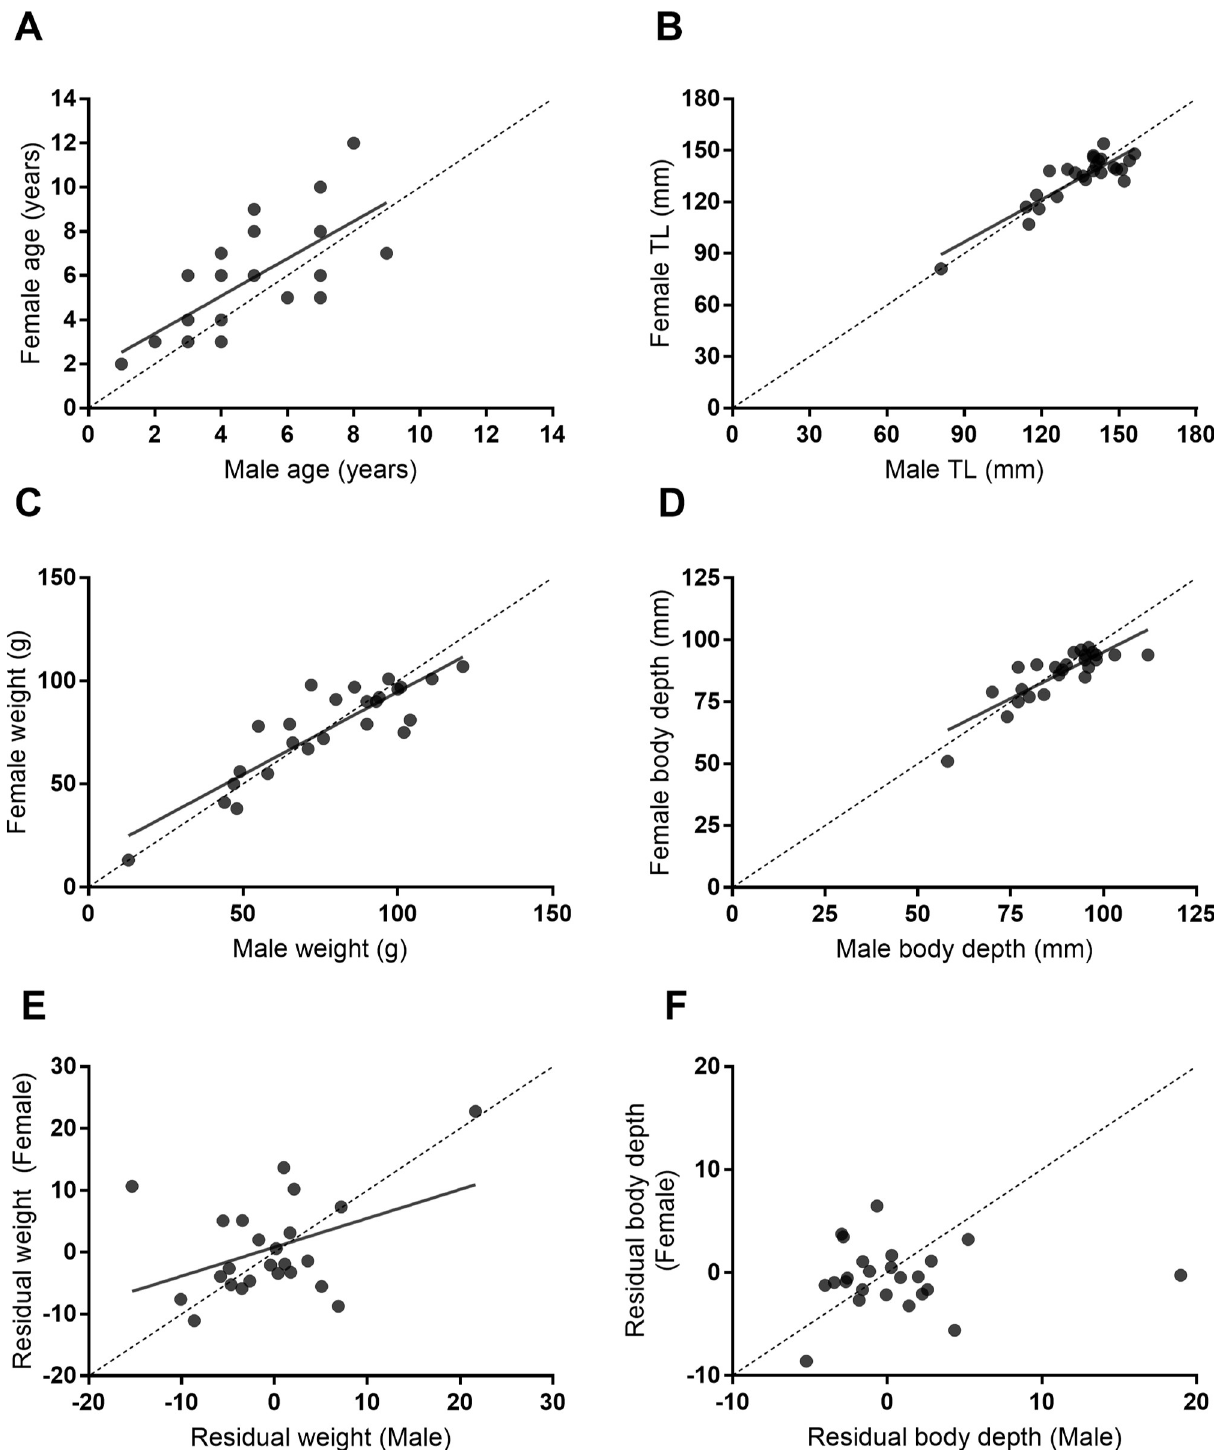
Fig 3. Correlations between males and females for: (A) age, (B) total length, (C) raw mass, and (D) raw body depth, in 25 pairs of Heniochus varius . Residual mass (E) and body depth (F) relationships are also shown, after accounting for relationships in the raw metrics to total length. Each point represents a pair, dotted lines indicates line of equality or the expected point if the male and female had an identical metrics, and solid lines represent linear estimates for statistically significant correlations (alpha = 0.05).